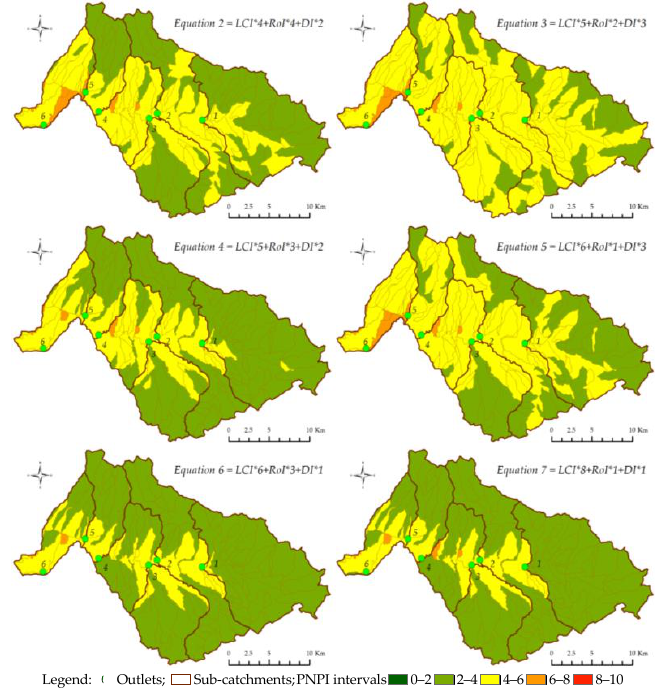
Figure 14. Spatial distribution of the different non-point pollution index (PNPI) classes at micro-catchment levels in 1997.